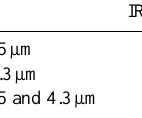
Table 4. Impact of spectral resolution, radiometric noise on the ac- curacy of the retrieval of CO 2 tropospheric columns, expressed rela- tive to the IRS1a/IASI accuracy (%). Three spectral ranges are used: either the 15µm band, or the 4.3µm band or both bands. Note that IRS1a/IASI and IRS2a CO 2 retrievals are only performed with the 15µm band. IRS1b IRS1c IRS2a IRS2b IRS2c